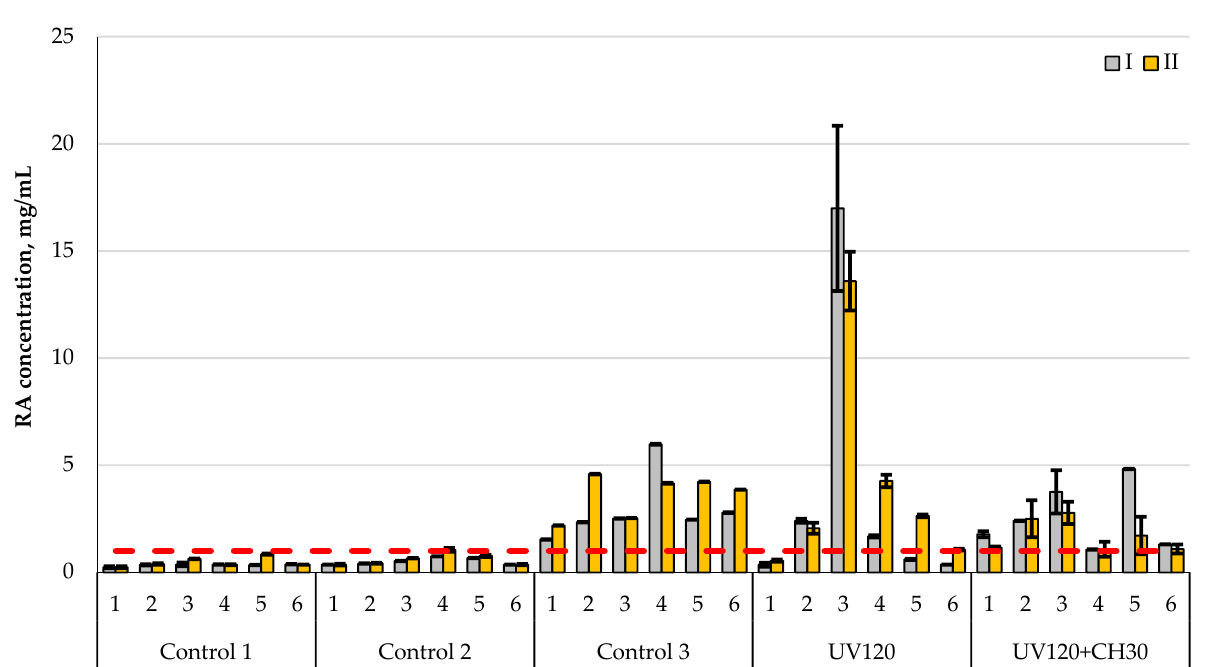
Figure 7. Comparison of cellulolytic activity of original (control 2) and treated A. niger (UV120 and UV120 + CH30) with a commercial enzyme preparation (control 3) at the following different process temperatures: I—37 °C; II—50 °C. Control 1—without microorganisms, control 2—original A. niger strain, control 3—enzyme preparation, UV120—mutant A. niger strain obtained by UV irradiation for 120 min; UV120 + CH30—mutant A. niger strain obtained by UV irradiation for 120